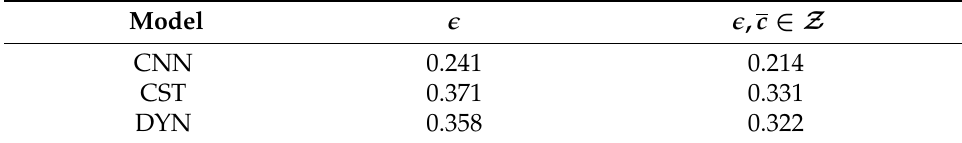
Figure 9. Hexbin plots of model predictions against ground truth on the R2 generalization set: ( a ) CNN model, ( b ) CST model, ( c ) DYN model. Table 4. R2 error values for c (cid:48) 2